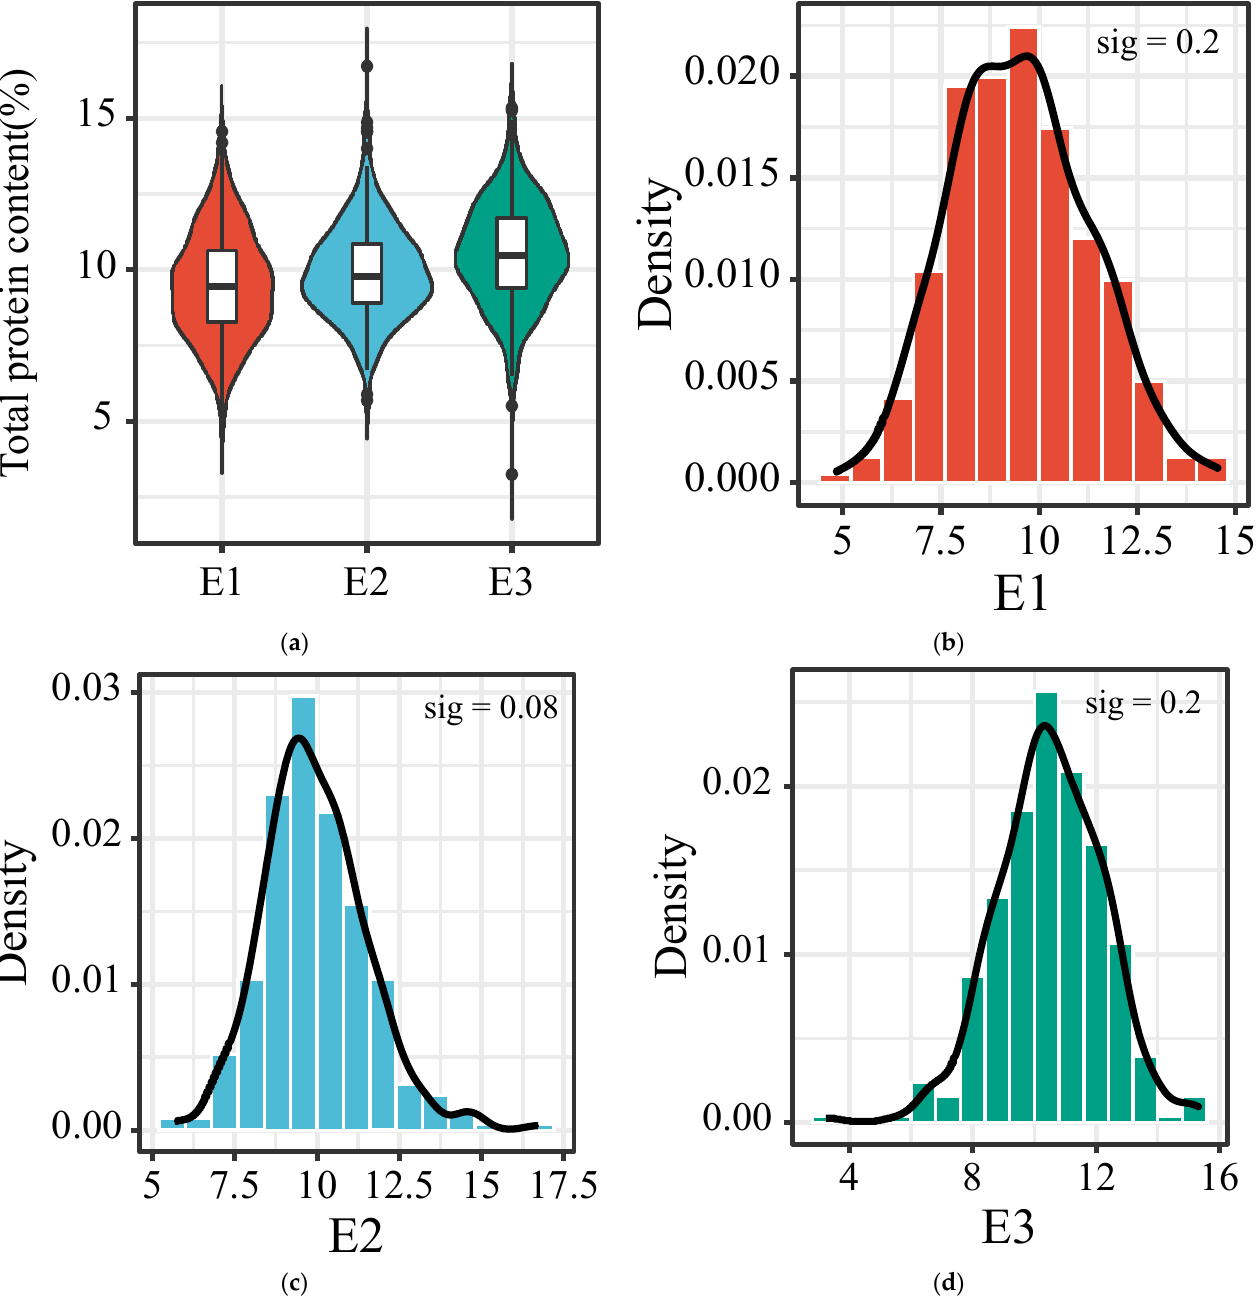
Figure 1. Distribution of TPC in a germplasm collection of foxtail millets grown at three experimental fields E1 (Datong city, 113°12 ′ 51 ′′ E, 40°22 ′ 58 ′′ N), E2 (Jinzhong city, 112°35 ′ 21 ′′ E, 37°25 ′ 16 ′′ N) and E3, (Jincheng city, 113°7 ′ 8 ′′ E, 35°32 ′ 6 ′′ N) in Shanxi province, China. ( a ) Grain TPC distribution characteristics of 301, 314 and 316 accessions harvested from E1, E2 and E3, respectively. ( b – d ) Histograms showing the normal distribution of TPC in three environments (E1, B; E2, C; E3, D) of foxtail millet. Significant test (sig) was also performed and labeled in each histogram. Next, the individual variety performance of the TPC trait was examined. The crop yield and grain protein quality were subjected to genotype × environment interactions and compensatory effects between traits [26]. Firstly, the top performer in each environment was identified. We found B198 (14.56%), B328 (16.71%) and B118 (15.34%) possessed the highest TPC in E1, E2 and E3, respectively. Next, the varieties less-affected by environmental